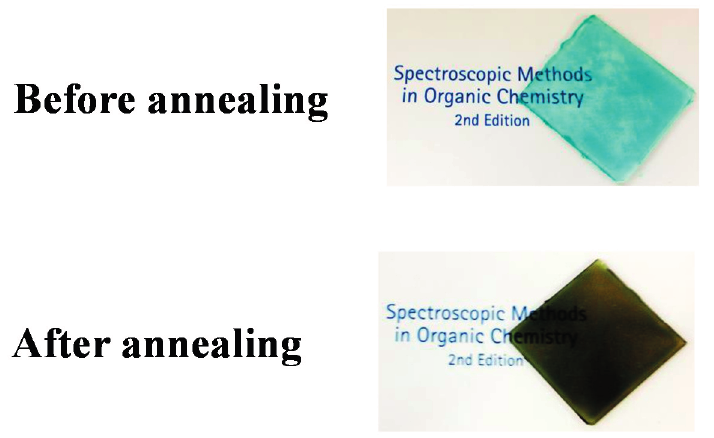
Figure 7. Photograph of film ( A ) (compounds 4 : 5 = 1:5) before and after